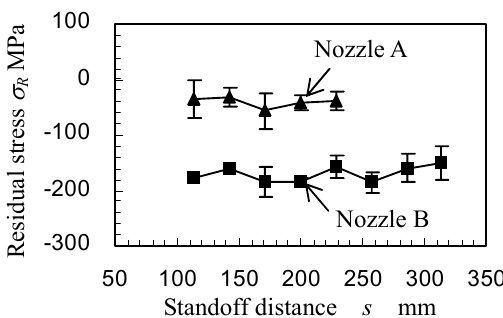
Fig. 7 Effect of nozzle outlet geometry on the introduction of compressive residual stress ( p = 200 MPa, p = 0.1 MPa, σ = 0.0005, t 1 2